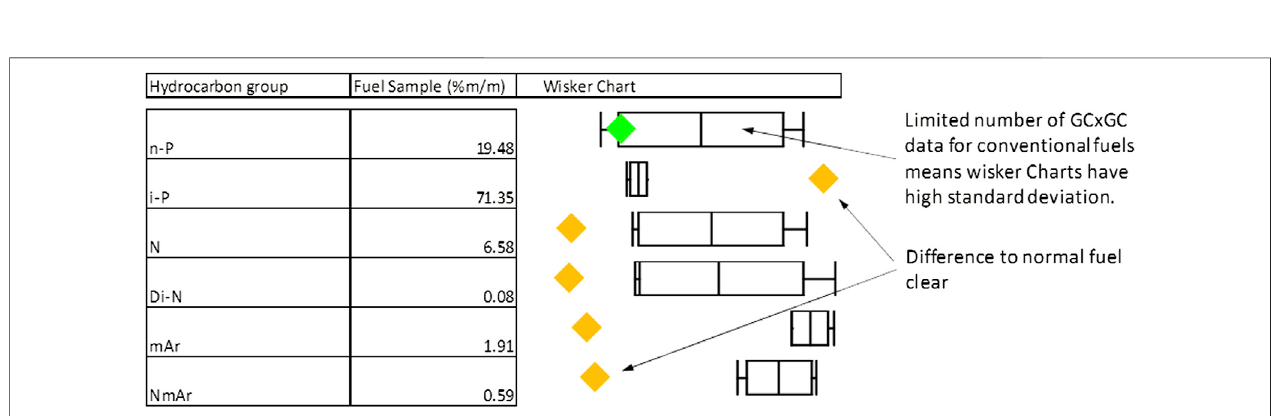
FIGURE 5 | Example comparison of candidate novel fuel to limited conventional fuels CGxCG database: Highlighting areas of concern for any fuel approval.